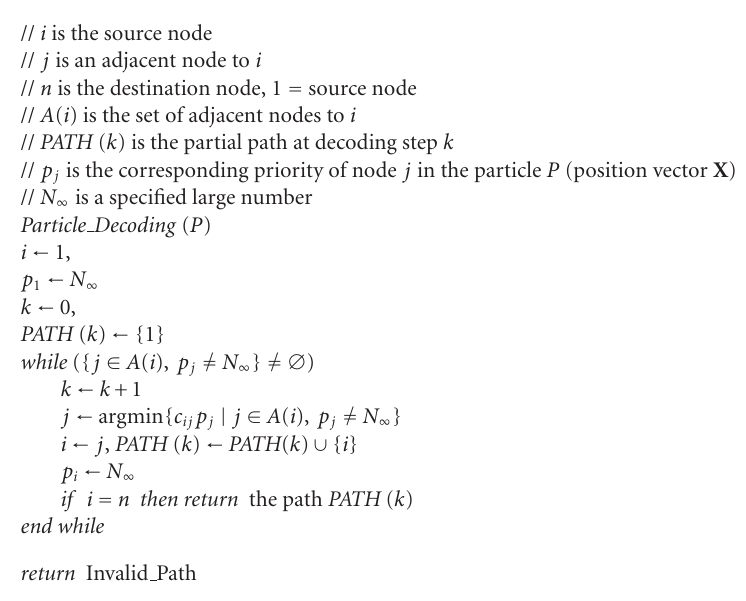
Algorithm 3 . 1 . Pseudocodes for cost-priority-based decoding